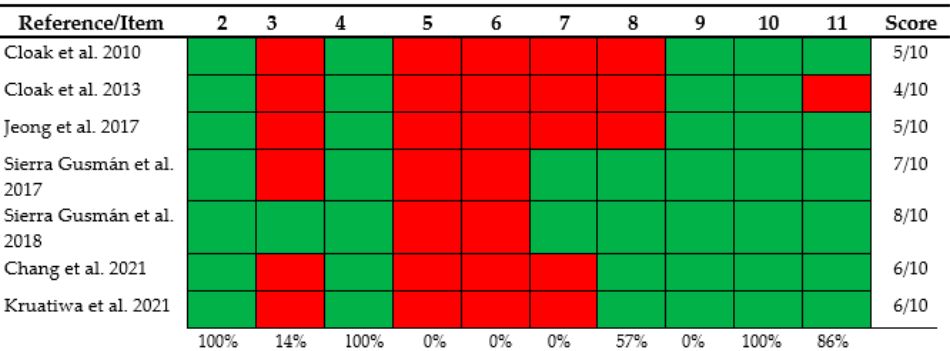
Figure 2. Assessment of the methodological quality of the included studies using the PEDro scale. (2) Subjects were randomly allocated to groups; (3) allocation concealed; (4) the groups were similar at baseline regarding the prognostic indicators; (5) was blinding of all subjects; (6) was blinding of all therapists who administered the intervention; (7) was blinding of all assessors who measured at